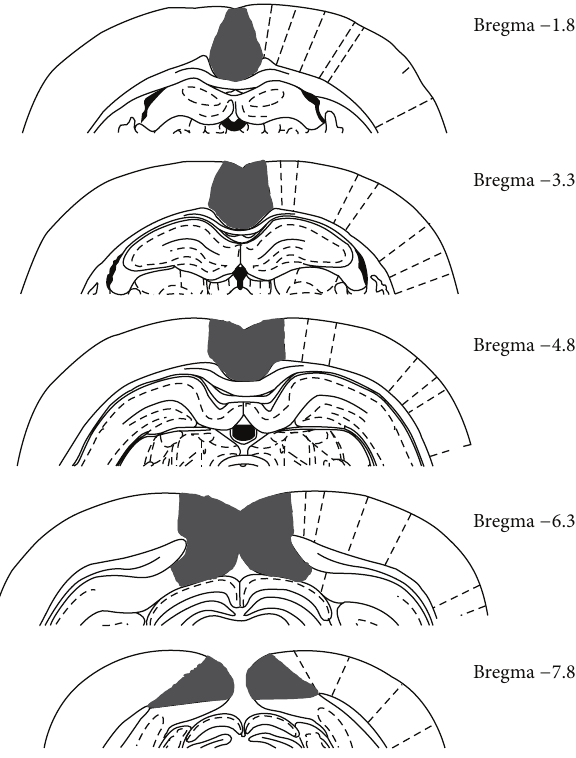
Figure 1: Schematic diagram illustrating the rostrocaudal extent of the RSC (black fill) in rats. Adapted from Paxinos and Watson [91].